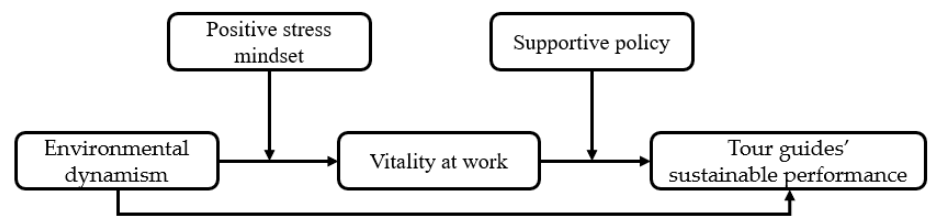
Figure 1. Hypothetical model of the current study.